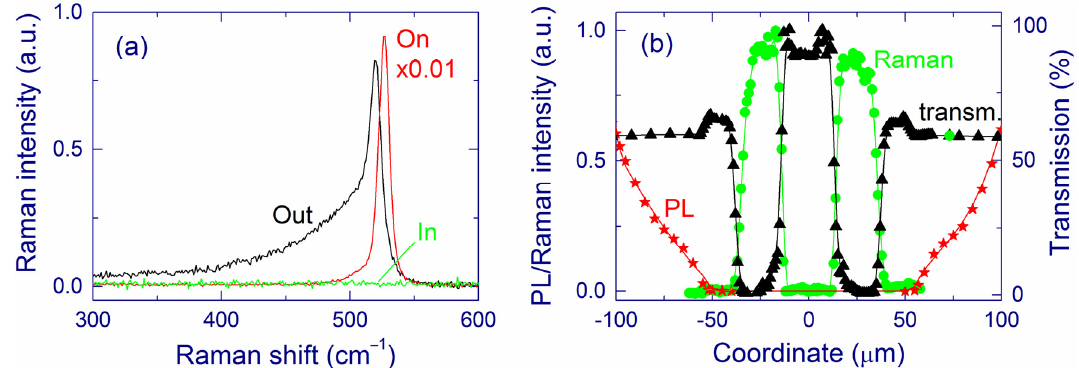
Figure 12. ( a ) Raman spectra of a laser-annealed 2- μ m-thick SiO x ( x ~ 1.7–1.8) film from regions in the center (in), on the ring (on), and outside the laser-annealed area (out). ( b ) Raman (circles), PL (stars), and transmission (triangles) cross-sections of the laser-annealed area. The cross-sections are measured in the vertical direction through the center of the laser-annealed area shown in Figure 11. Reproduced with permission from [140]. Copyright 2010, AIP Publishing